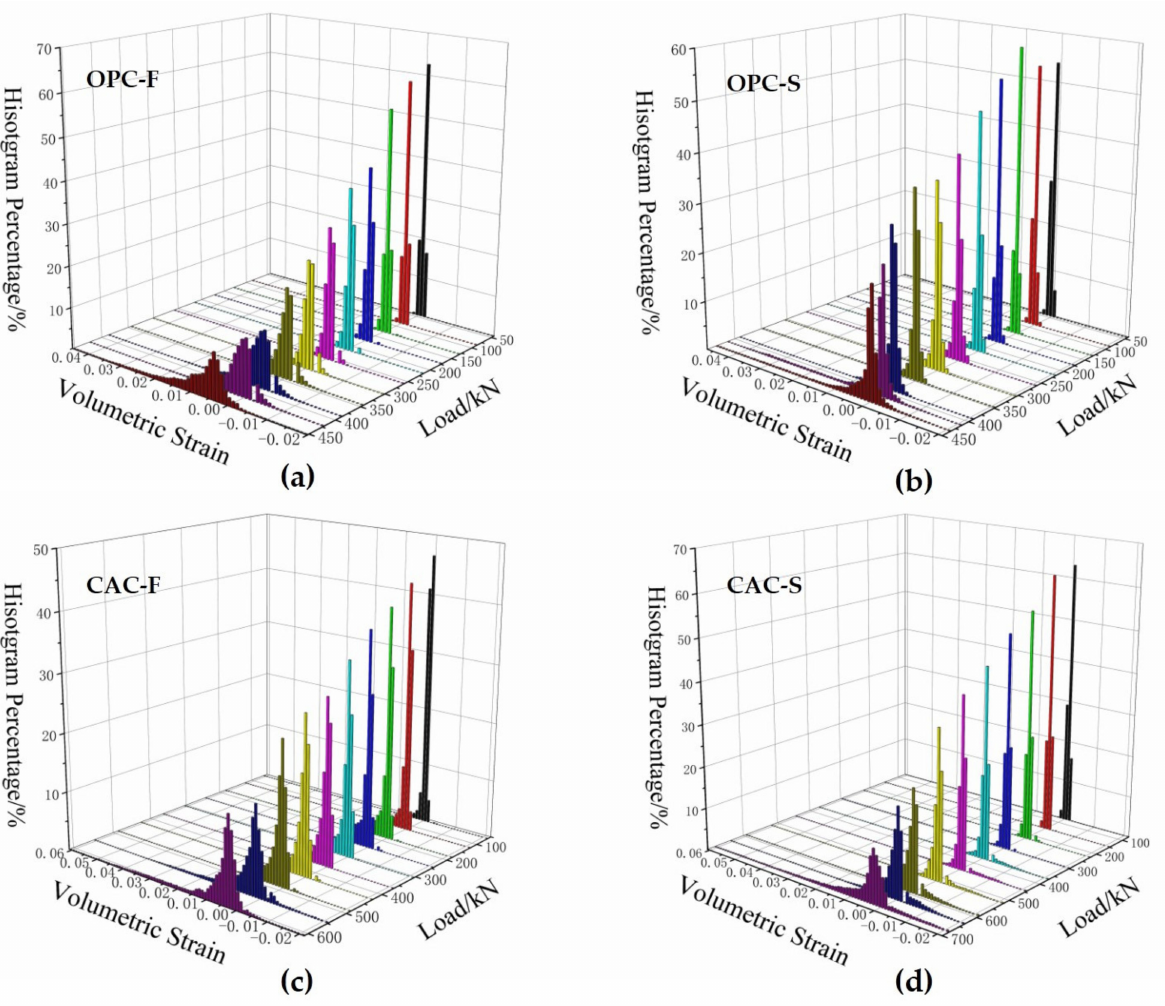
Figure 9. Histogram percentage of Volumetric strain for ( a ) OPC-F, ( b ) OPC-S, ( c ) CAC-F and ( d ) CAC-S, respectively, with the increase of compressive